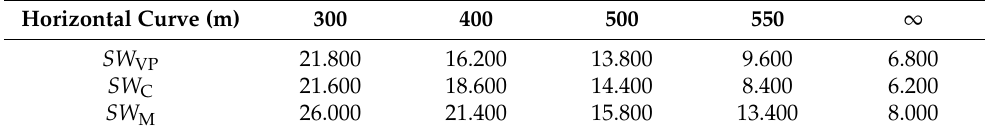
Table 4. Subjective workload over different radii.